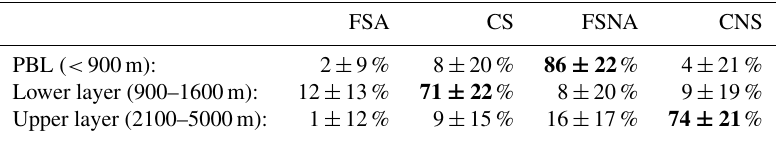
Table 2. Aerosol composition of the layers identified on 31 August 2018. The percentage of the dominant aerosol type in each layer is denoted in bold. FSA CS FSNA